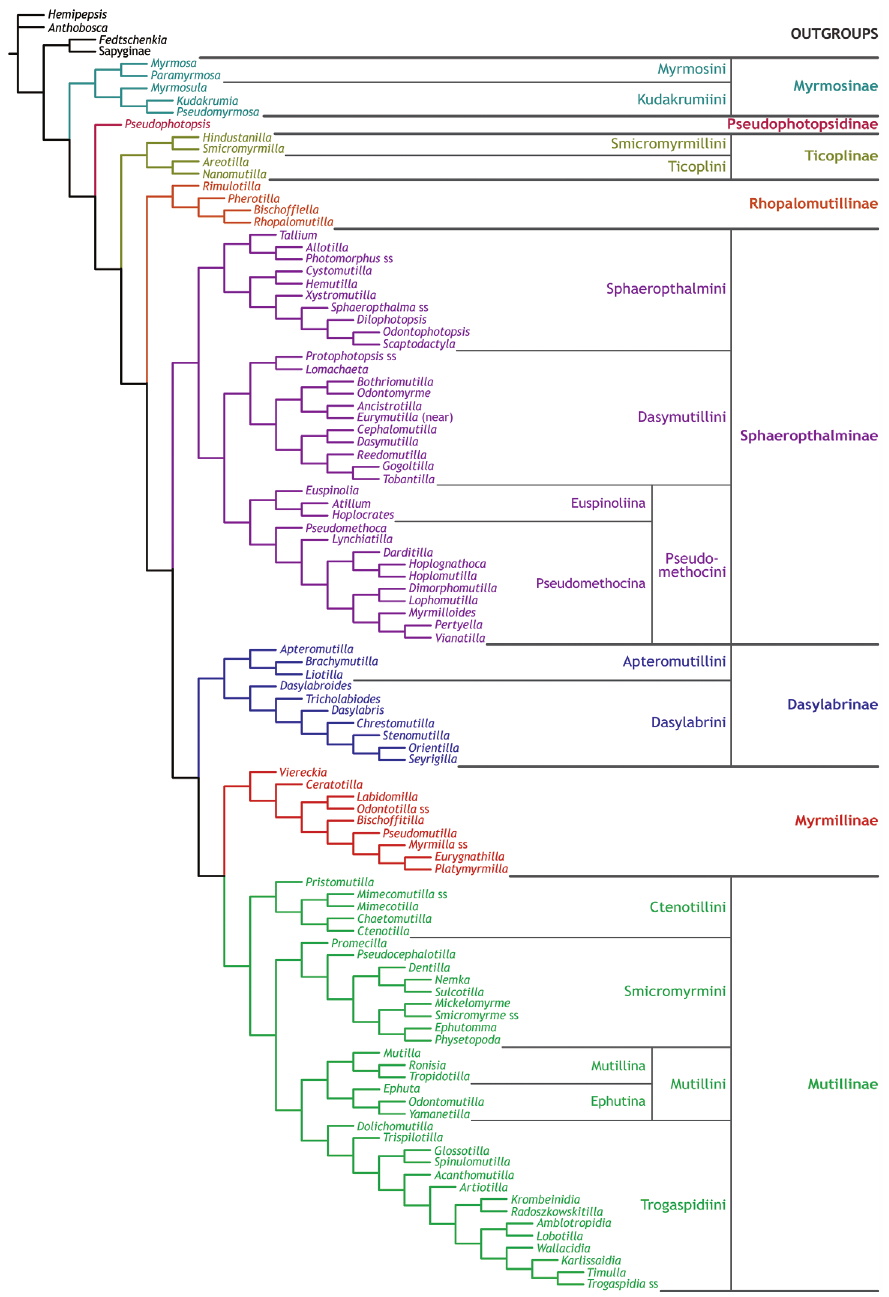
Figure 14. Proposed higher classification of Mutillidae as reflected by the rearranged tree (Fig. 13) of length about 1% greater than the previously preferred tree (Fig. 5) (lengths = 2858 vs 2828 for additive characters, 2671 vs 2646 for non-additive characters). (See Appendix 4 for classification including all cur- rently valid genera and